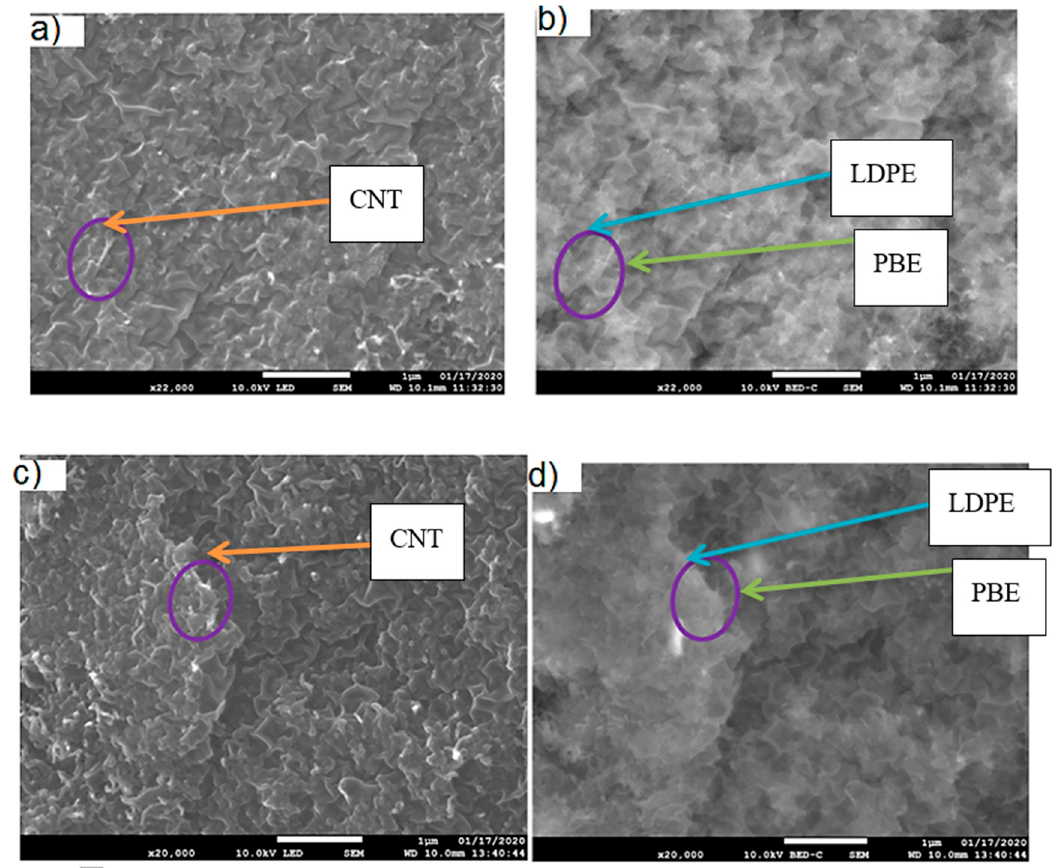
Figure 18. SEM images in the transverse direction of the one-step ( a , b ) and two-step ( c , d ) 60 ( LDPE KB 16.7 CNT 4.2 ) /40PBE blend: location of the CNT nanoparticles. ( a ) and ( c ) are in the normal LED mode and ( b ) and ( d ) are in backscattered mode. LDPE is whiter and the PBE is darker.